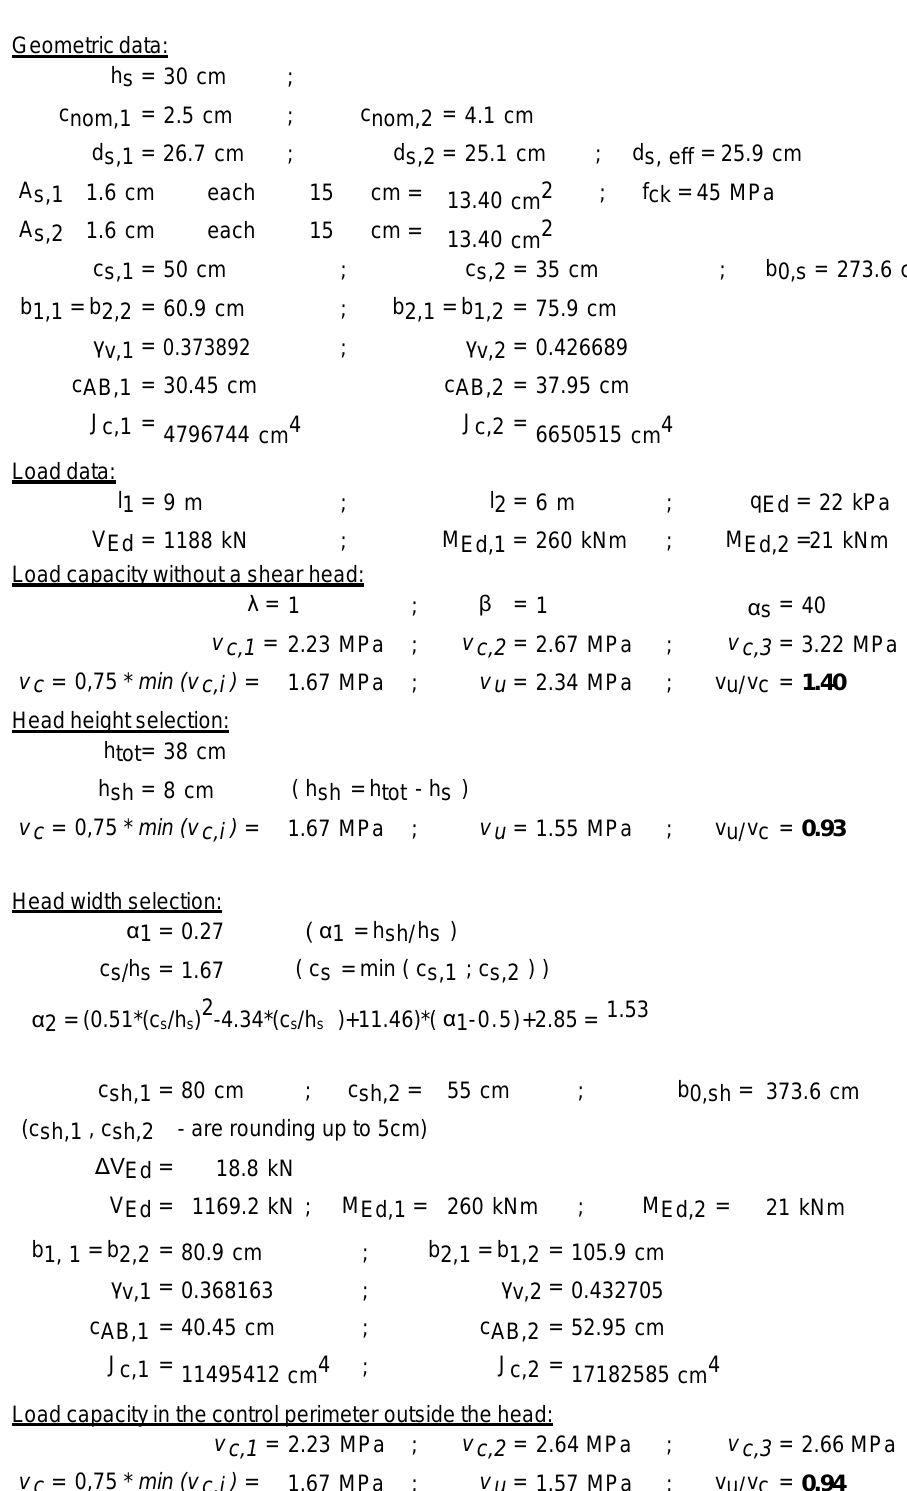
Figure A8. Verification example no. 4—ACI 318.